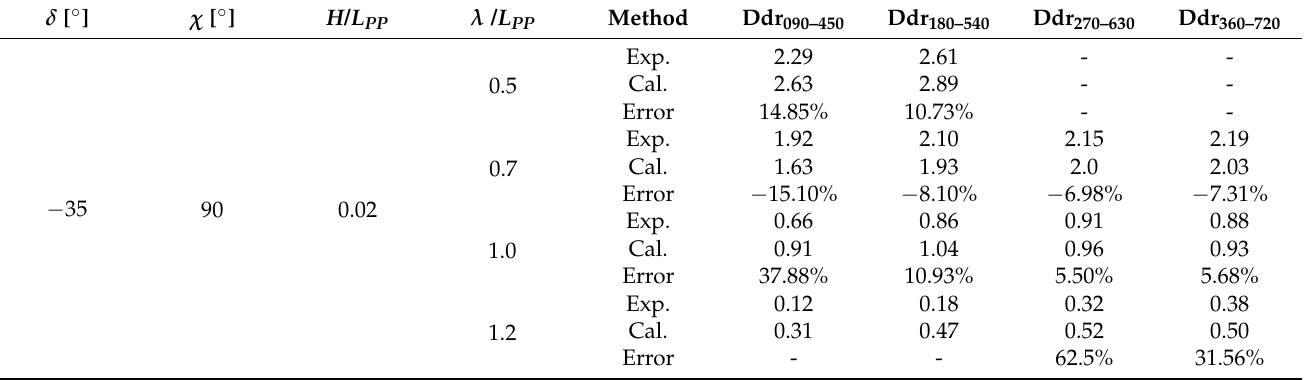
Table 8. Comparisons of trajectory drifting distances in beam waves [unit: L pp (ship